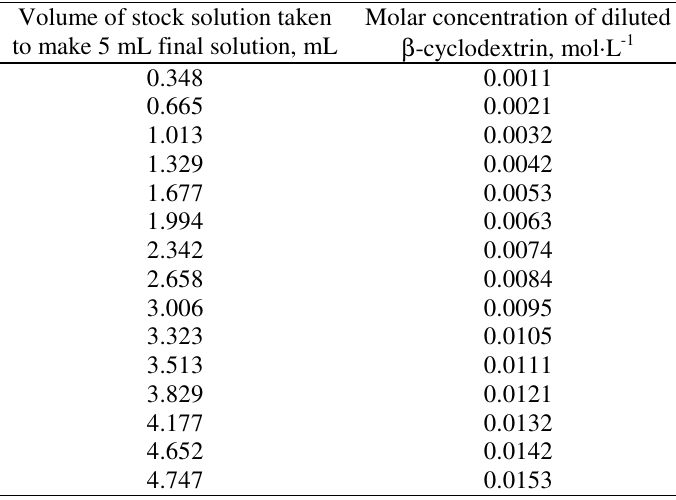
Table 1. Solutions of the Host - ( b -